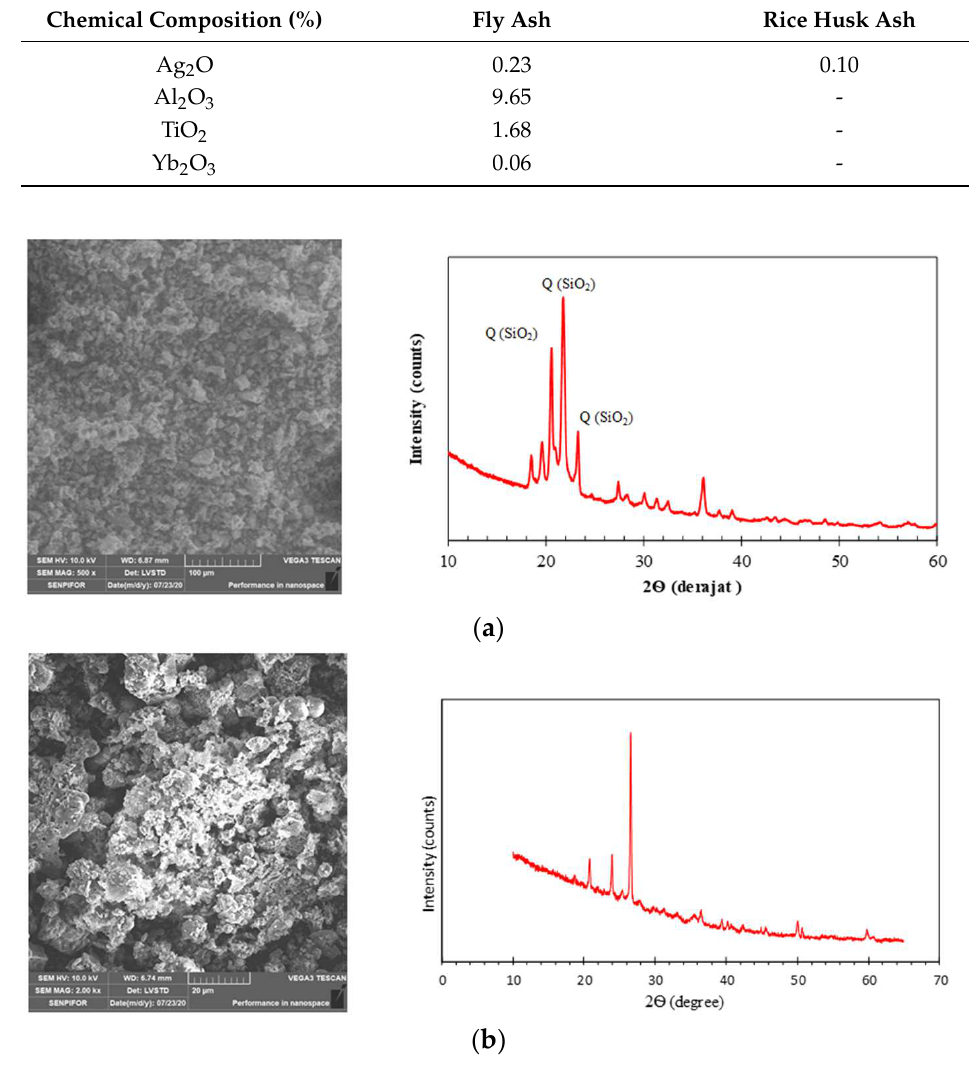
Figure 1. SEM and XRD from fly ash and RHA, (a) RHA, (b) Fly